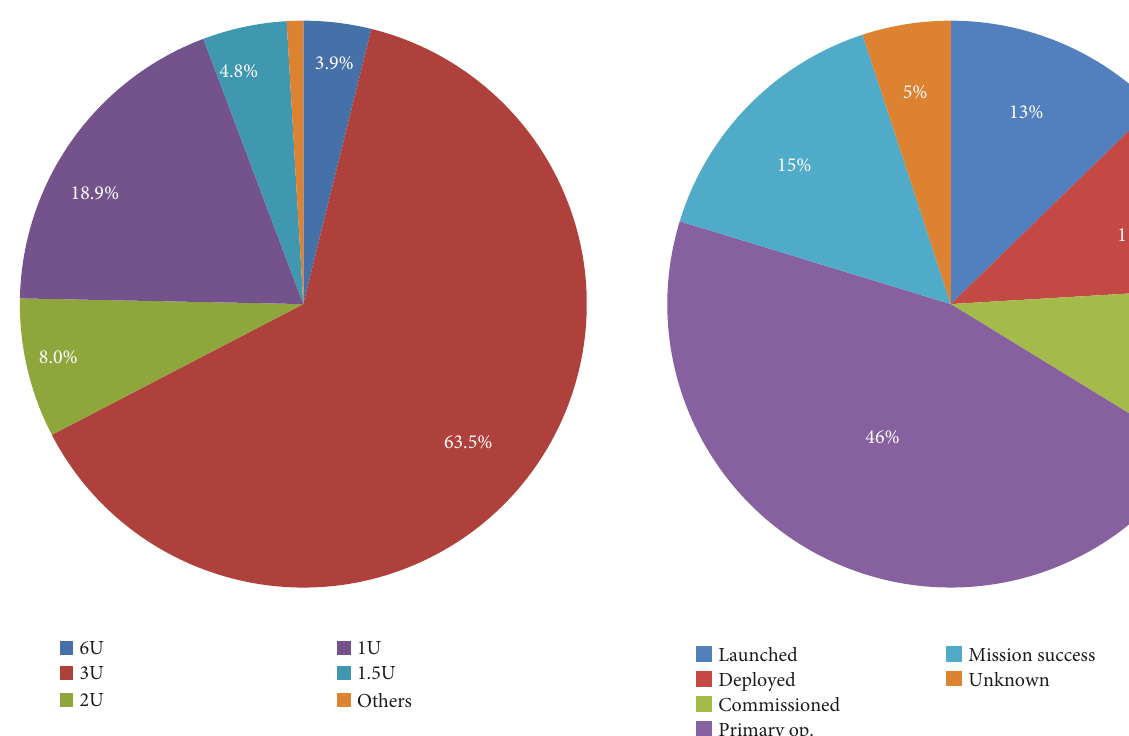
Figure 5: Distribution of CubeSats according to their con fi guration.